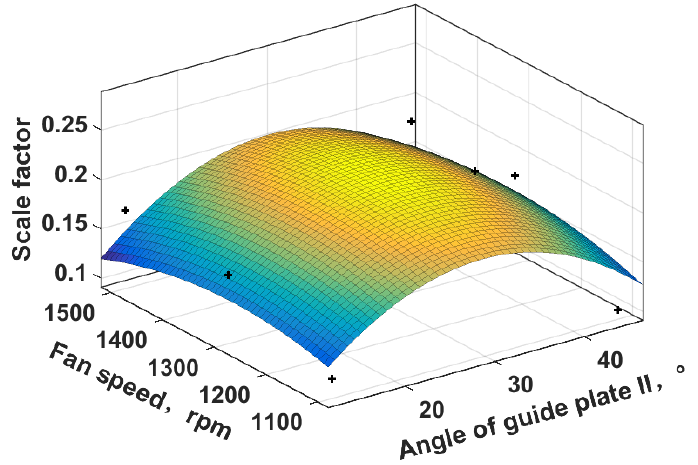
Figure 12. Scale factor between sieve loss in monitoring area and total sieve loss.